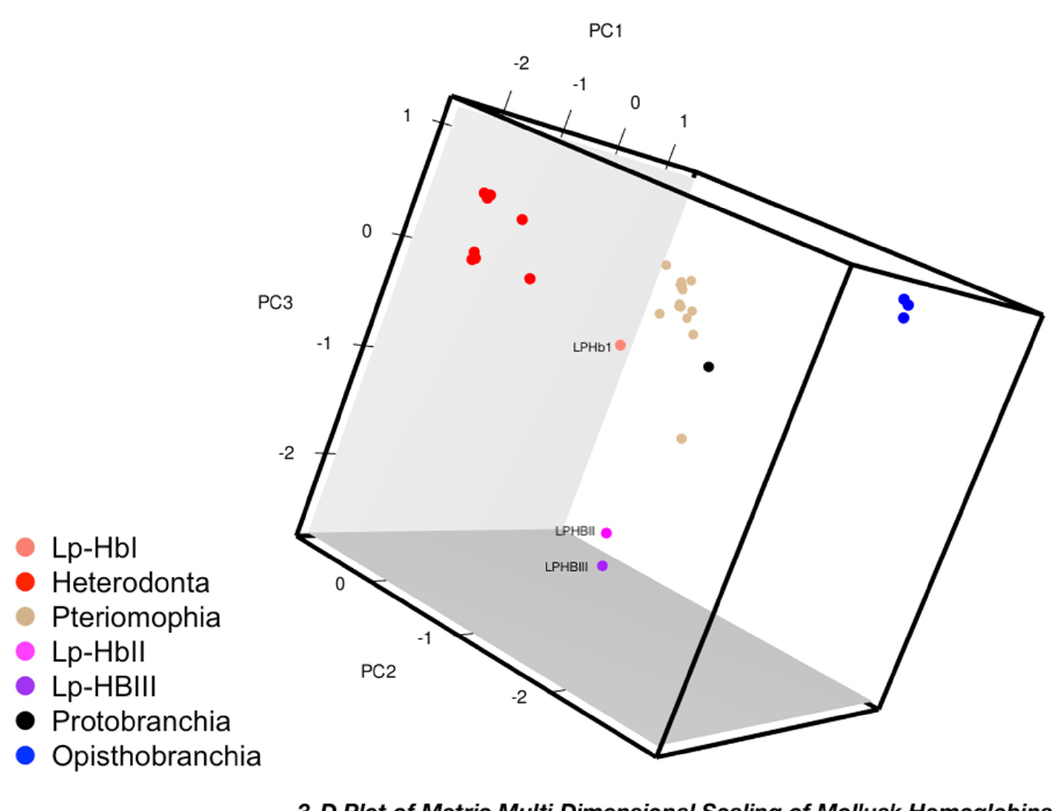
Figure 5. 3D representation of the mollusk globins sequence space. A trimmed multiple sequence alignment of 32 homologous mollusk globins was analyzed by MMDS, with distances based on the JTT distance matrix. The 3D space is defined by the first three components of the MDS analysis. HbI Lp is colored ‘salmon’, HbII Lp is colored in magenta and HbIII Lp is colored purple. The rest of the sequences are color coded according to mollusk sub-families they belong to: colored in red are Heterodonta subclass, in tan are the Pteriomophia subclass, in blue are the Opisthobranchia subclass, and in black the Bivalve, Y. eightsi , member of the Protobranchia subclass.